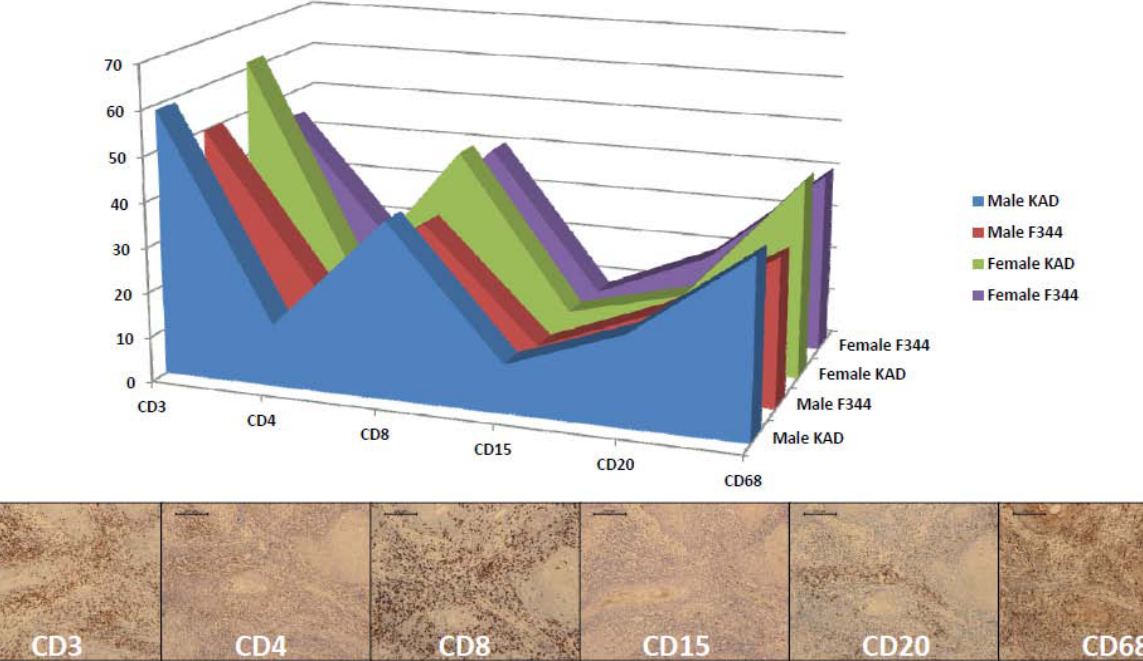
Figure A2. Number of inflammatory cells immunohistochemically positive for CD3, CD4, CD8, CD15, CD20 and CD68 in the tongue tissues of the KAD and F344/NS1c rats given 4-NQO. The values are represented as the means. The bars in the representative photos are 200 µ